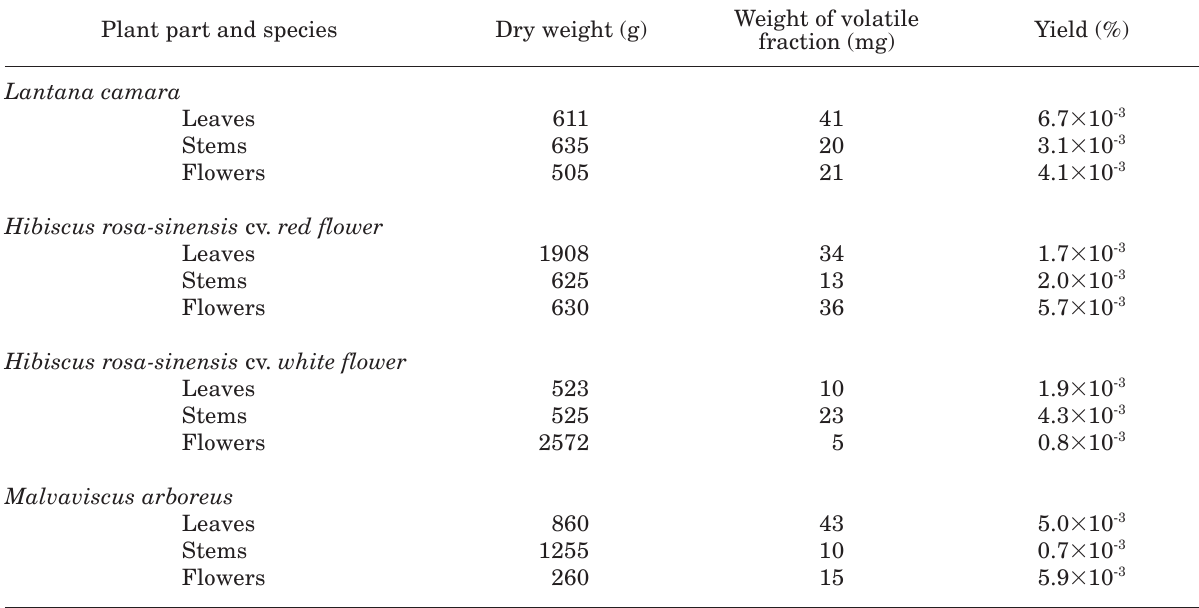
Table 1. Plant parts, dry weight, weights and yield of the extracts of the four plants used in this study.